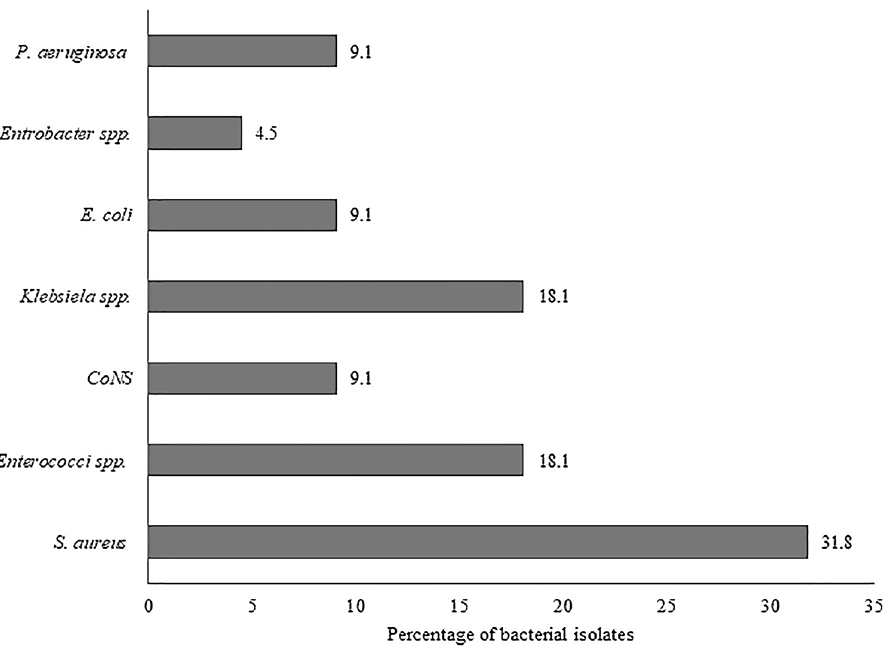
Figure 1. Types and percentage of blood culture isolates among adult patients at AMGH, south Ethiopia, from 1st June to 31st August,